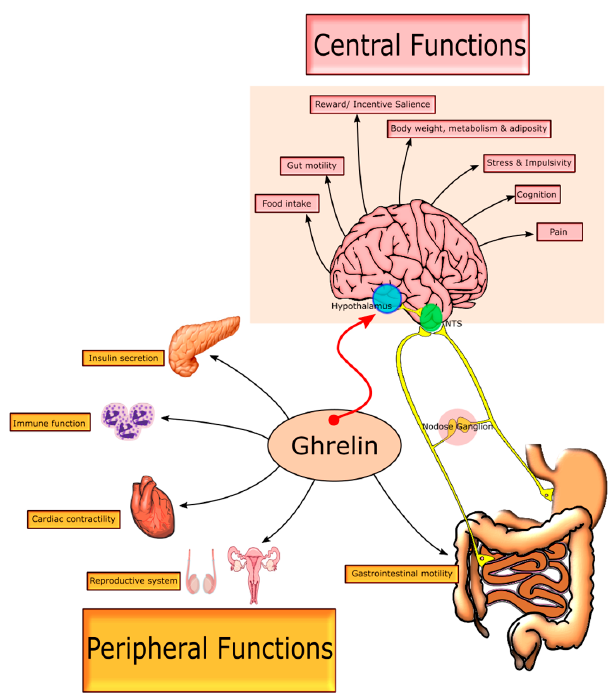
Figure 1. This combines the documented methods of ghrelin’s action after its release from the stomach, or exogenous administration. Ghrelin travels via the circulation to activate the growth hormone secretagogue receptor (GHSR-1a) in the arcuate nucleus and the nucleus tractus solitarius (NTS) after circumventing the blood-brain barrier (BBB), denoted by the red arrow. Peripheral signals are conveyed to the central nervous system (CNS) via vagal afferents also. Activation of the GHSR-1a leads to a multitude of centrally and/or peripherally mediated effects.